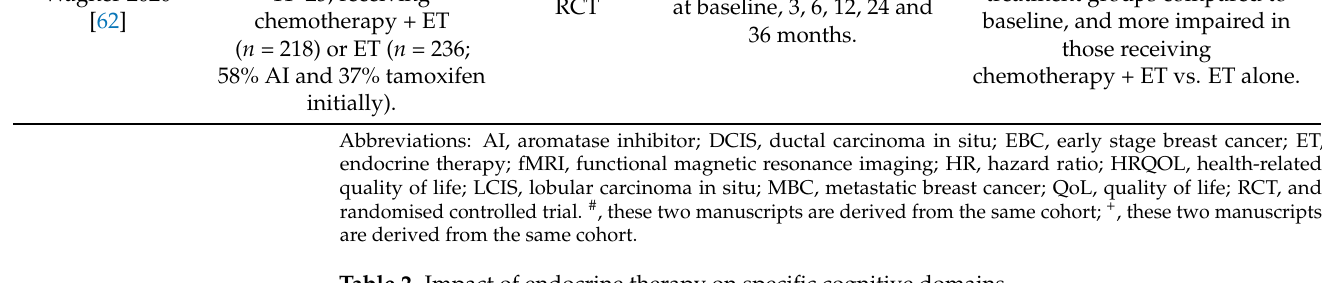
Table 2. Impact of endocrine therapy on specific cognitive